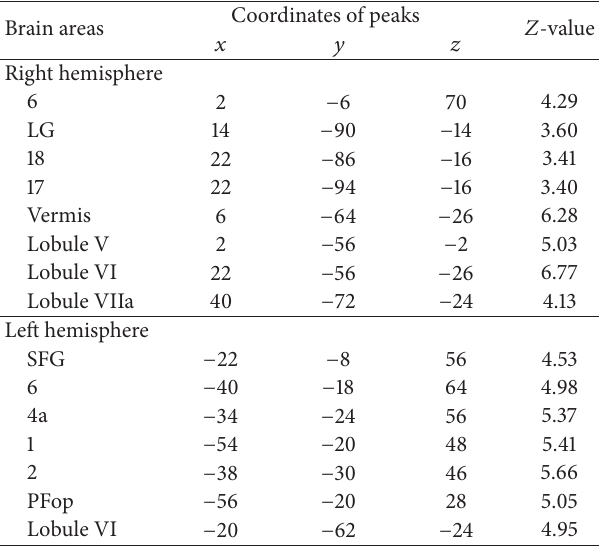
Table 3: Brain regions active during execution period (TASK